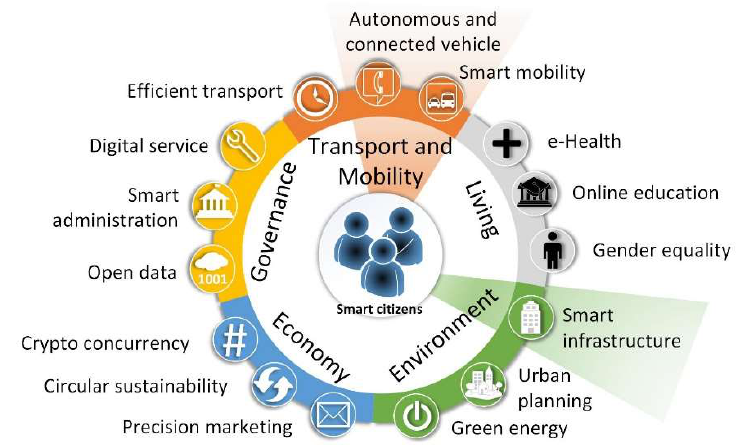
Figure 1. Person-centric adaptation of the Smart City Wheel proposed in [1]. The topics shaded in orange and green concern this research.